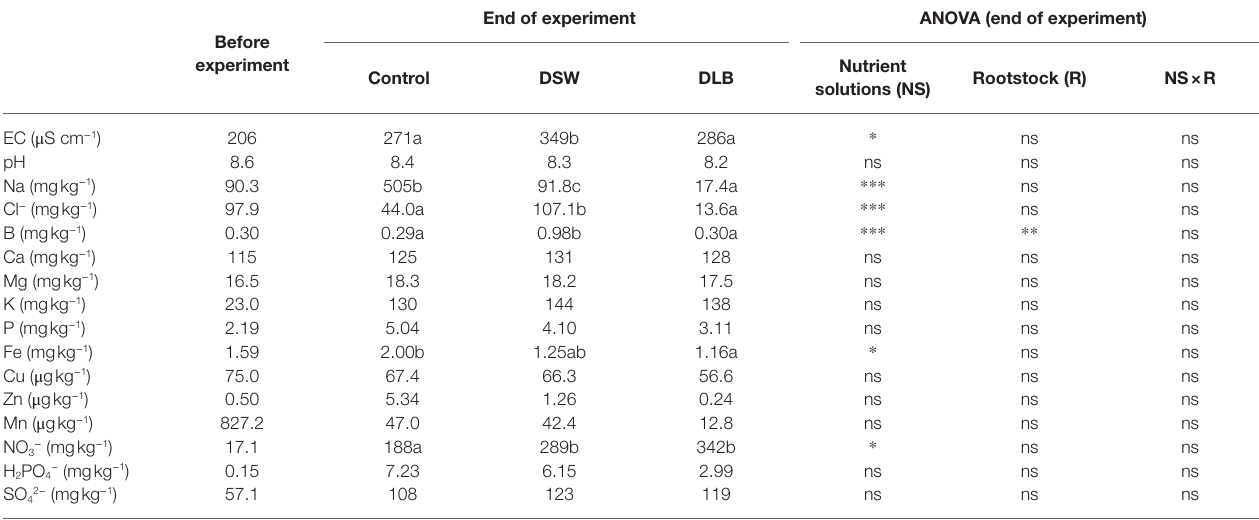
TABLE 2 | Substrate chemical properties for the initial substrate (before the experiment) and at the end of the experiment, after 7 months of irrigation with nutrient solutions of different characteristics: Control, DSW, and DLB.